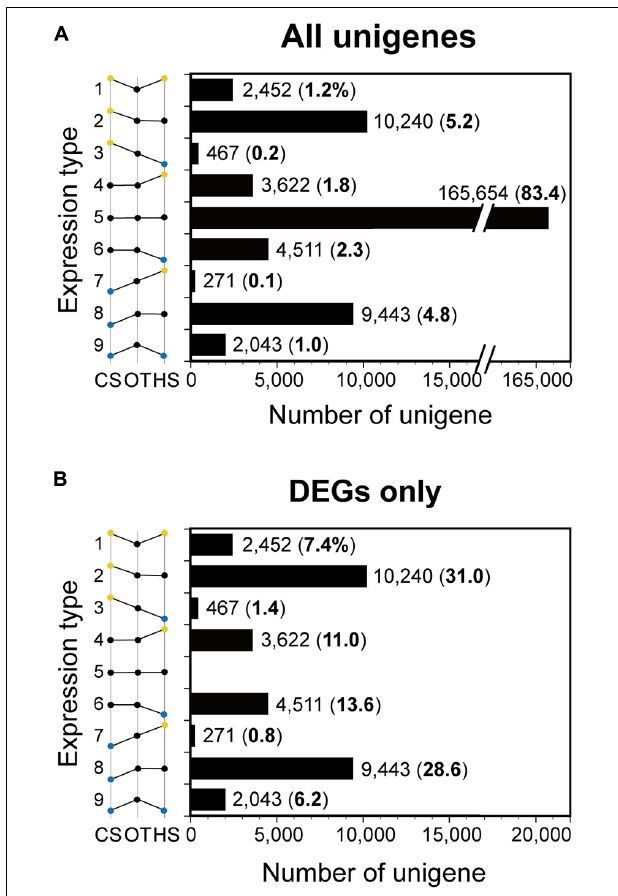
FIGURE 7 | The number of unigenes of Biecheleriopsis adriatica in each expression type. The numbers in parenthesis indicate percentages of the number of the unigenes relative to that of (A) all unigenes and (B) differentially expressed genes (DEGs). CS, cold stress; OT, optimal temperature; HS, heat